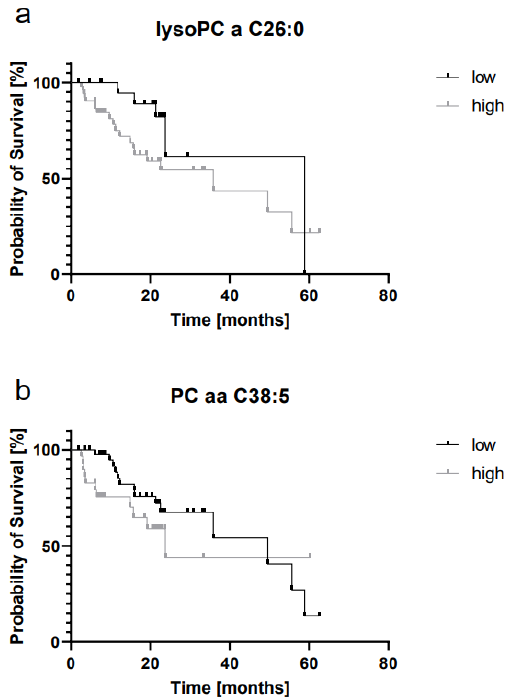
Figure 3. MV lipids are prognostic markers for overall survival in breast cancer. Kaplan–Meier curves ( a , b ): patients with high concentrations of lysoPC a C26:0 and PC aa C38:5 show a shorter OS ( p ≤ 0.05, Gehan–Breslow–Wilcoxon test).